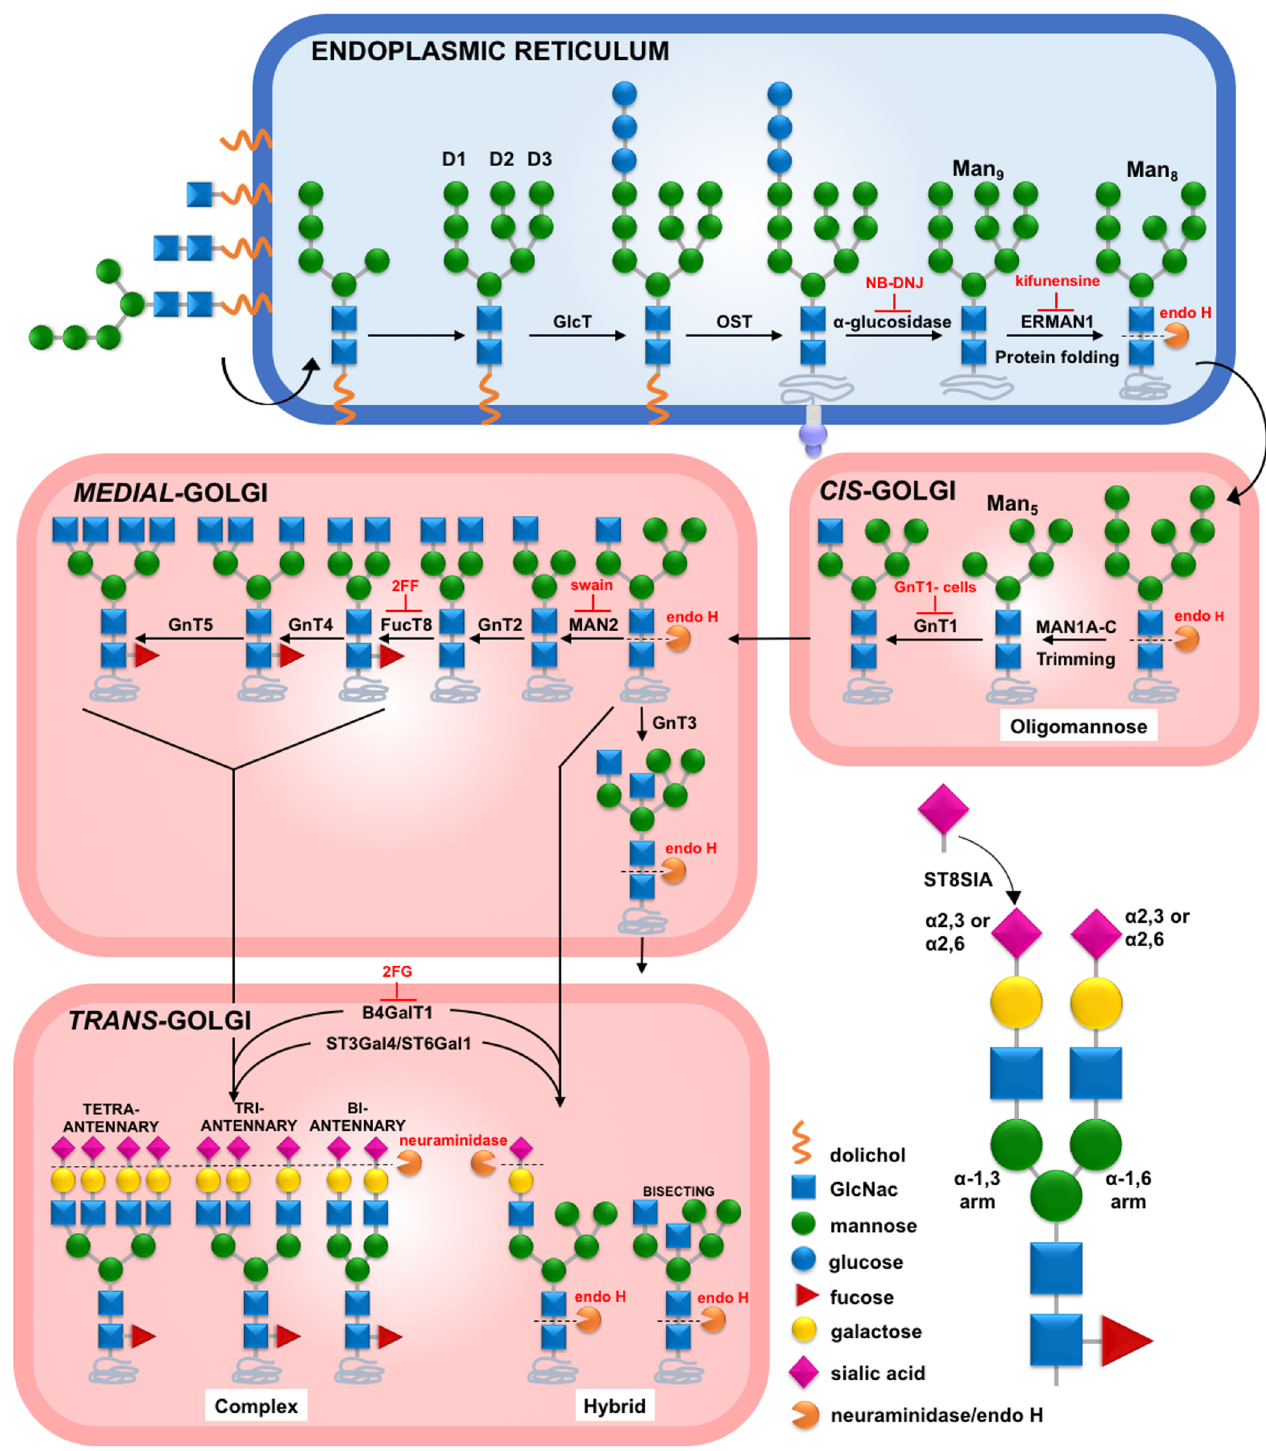
Fig 1. N-linked glycosylation and GE. A dolichol phosphate-linked precursor consisting of 2 membrane-linked N-acteylglucosamine (GlcNac) moieties and 5 mannose (Man) forms on the cytoplasmic surface of the endoplasmic reticulum (ER), then flips to the lumen. Further mannose moieties are added to create 3 termini (D1-D3), to which glucose moieties are added by glucosyltransferase (GlcT). This is transferred to Asn-X-Ser/Thr sequons of a nascent protein by oligosaccharyltransferase (OST). The 3 terminal glucose residues are then removed by α -glucosidase to form Man 9 GlcNAc 2 (Man9)—a step that is inhibited by N-Butyldeoxynojirimycin (NB-DNJ). The terminal D2 mannose is then cleaved by α -mannosidase 1 (ERMAN1)—a step that can be inhibited by kifunensine.